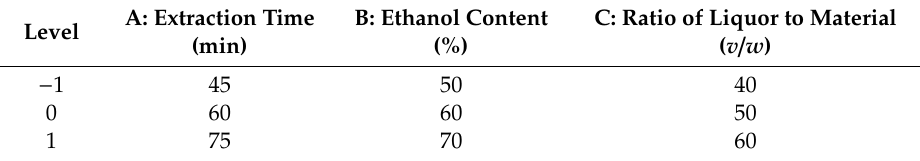
Table 1. Level and code of independent variable used for response surface